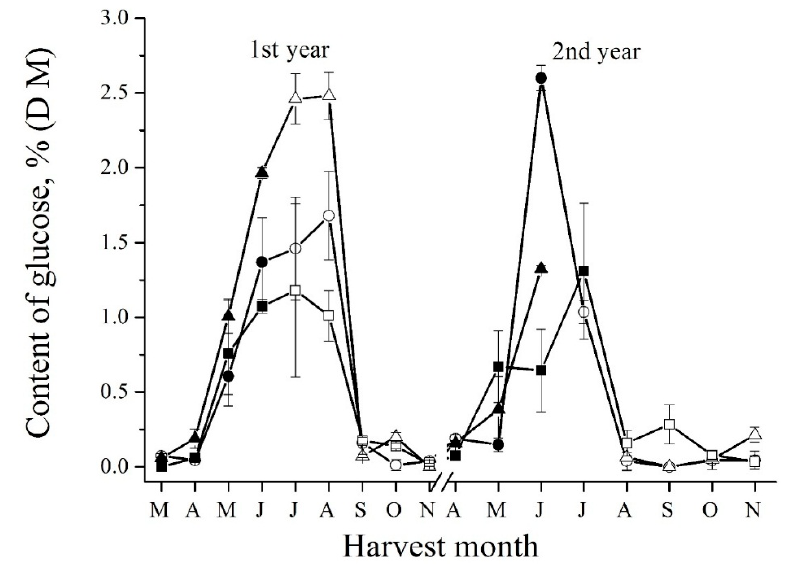
Figure 4. Seasonal fluctuations of glucose determined by enzymatic method in the tubers of Sauliai ( ● , ○ ), Albik ( ▲ , ∆ ), and Rubik ( ■ , □ ); spring tubers: ● , ▲ , ■ ; summer and autumn tubers: ○ , ∆ , □ .